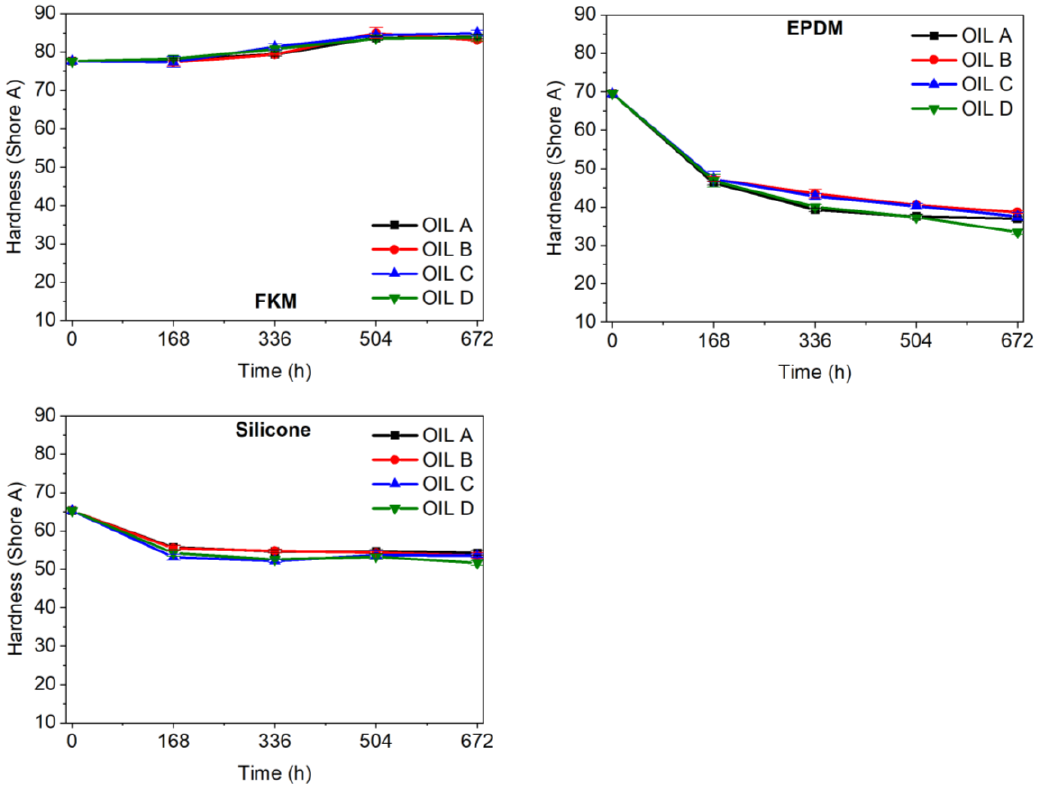
Figure 2. Changes in hardness of the FKM, EPDM, and silicone after aging in oils A, B, C, and D.